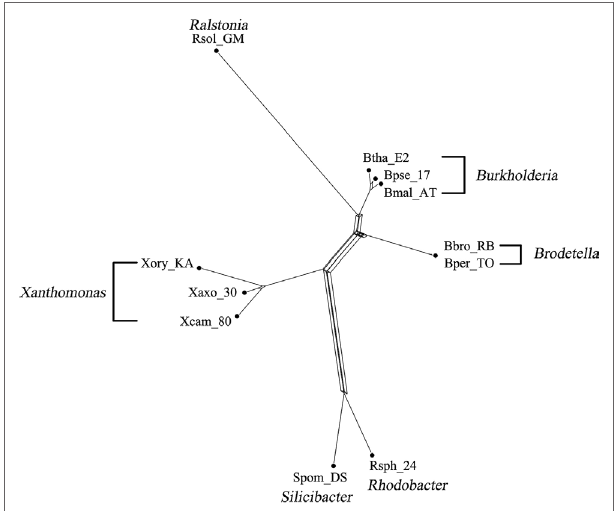
FIGURE 3 | The reconstructed QS-Net network of 11 GC-rich bacteria.